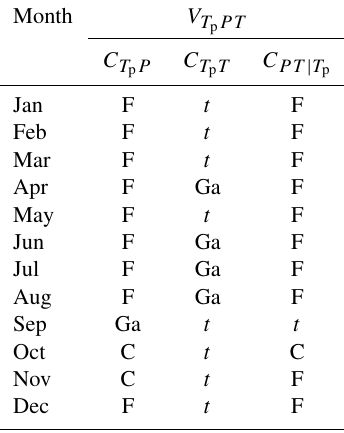
Table 2. Bivariate copula families selected by AIC for V T , p E where F stands for Frank, Ga for Gaussian, G for Gumbel, C for Clayton, J for Joe and t for the t -copula